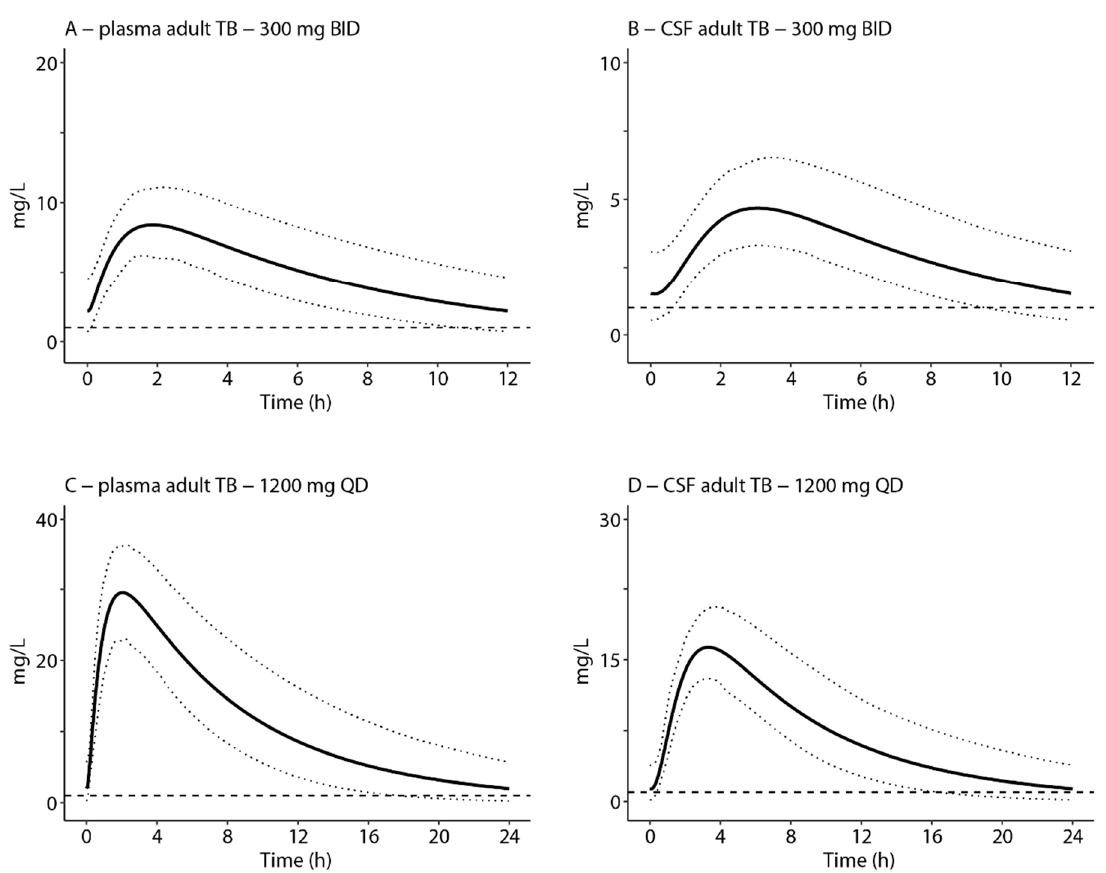
Figure 4. Simulations of linezolid concentration–time profiles in plasma and cranial CSF after 300 mg BID ( A , B ) and 1200 mg QD ( C , D ) in adult TB patients. The x -axis indicates time after the last dose. The solid black lines indicate simulation of the mean profile, and the dotted lines indicate the 5th and 95th percentiles of the mean. Simulations were performed based on plasma PK parameters values in adult TB patients as described by Diacon et al. (2020) [32]. Dashed horizontal lines indicate the MIC value of 1 mg/L linezolid for Mycobacterium tuberculosis [30,31]. In the clinical study provided, linezolid was provided as a monotherapy.